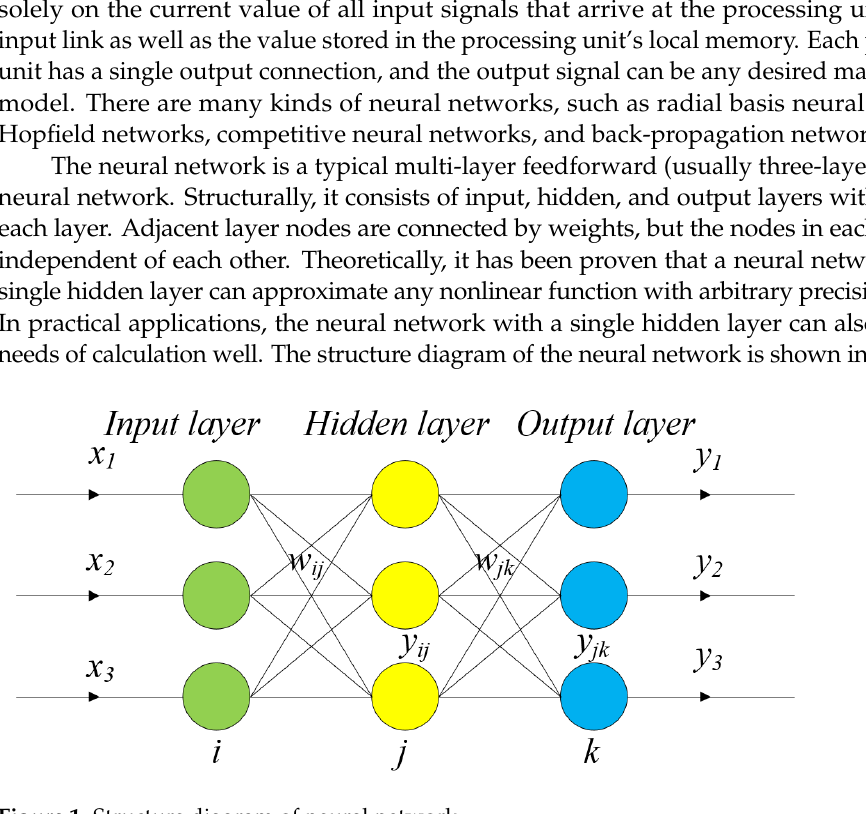
Figure 1. Structure diagram of neural network.